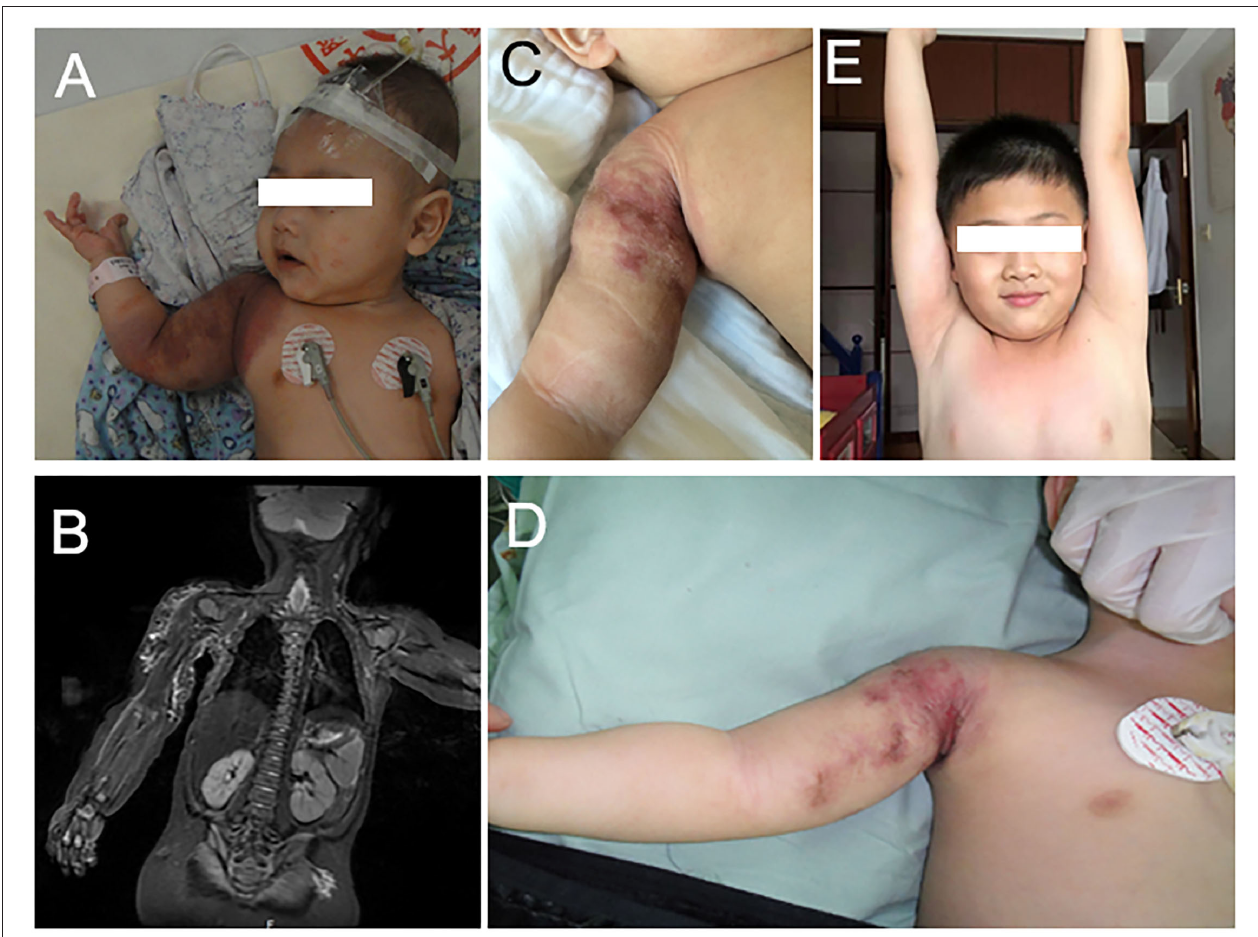
FIGURE 2 | (A) The patient was diagnosed with KHE with KMP on his right shoulder and arm at 4 months. (B) Magnetic resonance imaging with contrast enhancement revealed the vascular lesion on his right shoulder and arm. (C) The lesion recessed obviously after three courses of ILP and sclerotherapy. (D) The tumor recessed after three courses of ILP and sclerotherapy. (E) The tumor absolutely recessed at 6